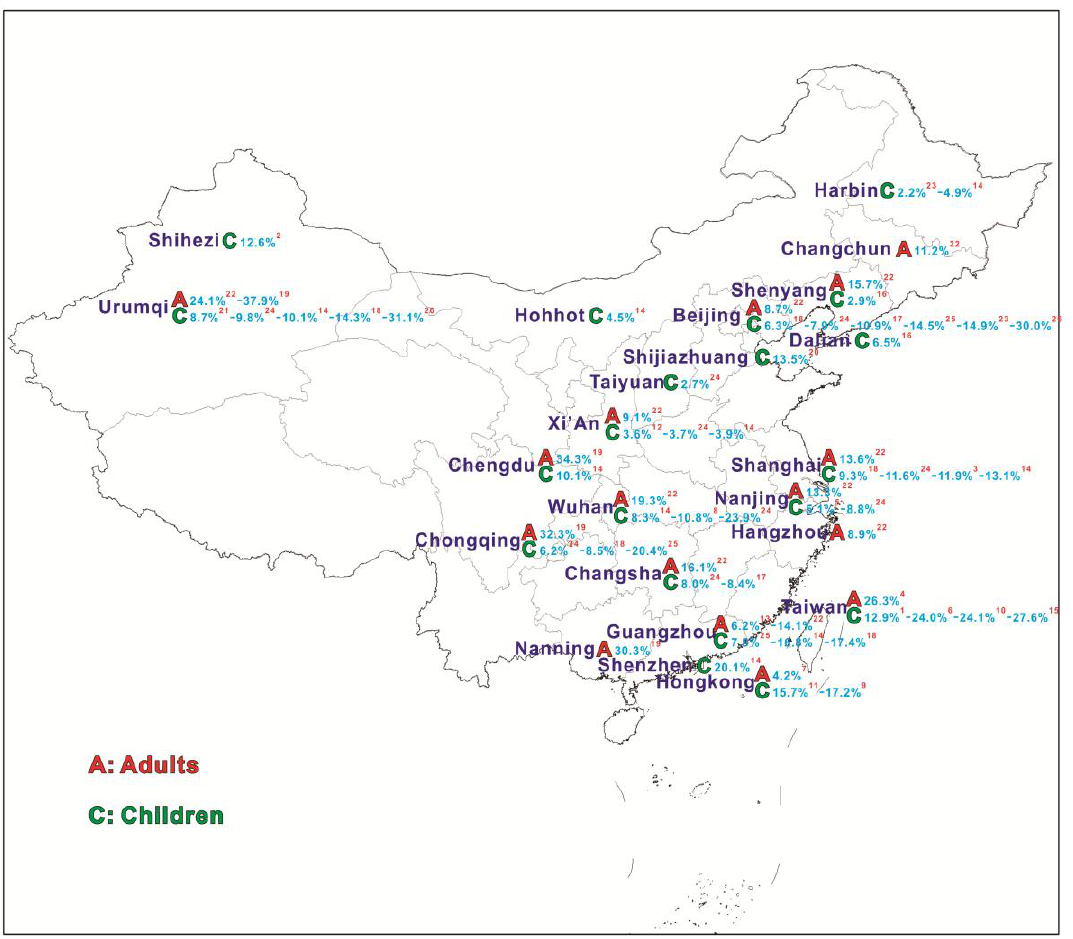
Figure 1. Comprehensive published prevalences of AR in adults and children in different Chinese cities.